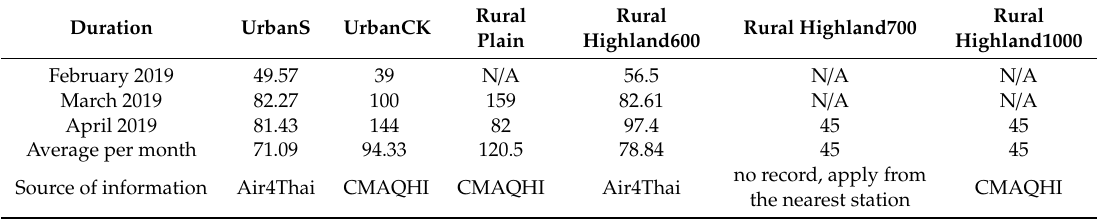
Table 2. The average PM 2.5 concentrations ( µ g / m 3 ) during February to April 2019 in study